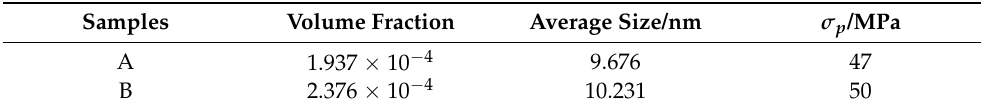
Table 4. Calculated volume fraction, average size of the carbide, and the calculated σ p of the experimental steel.